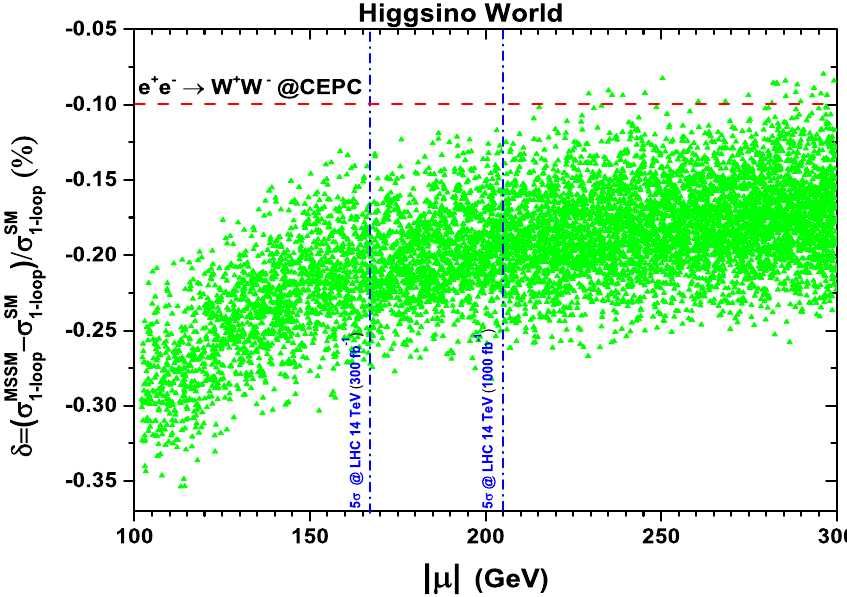
+ is the cosine of the e + decay angle with respect to the W + direction in the CM system (right panel) W +